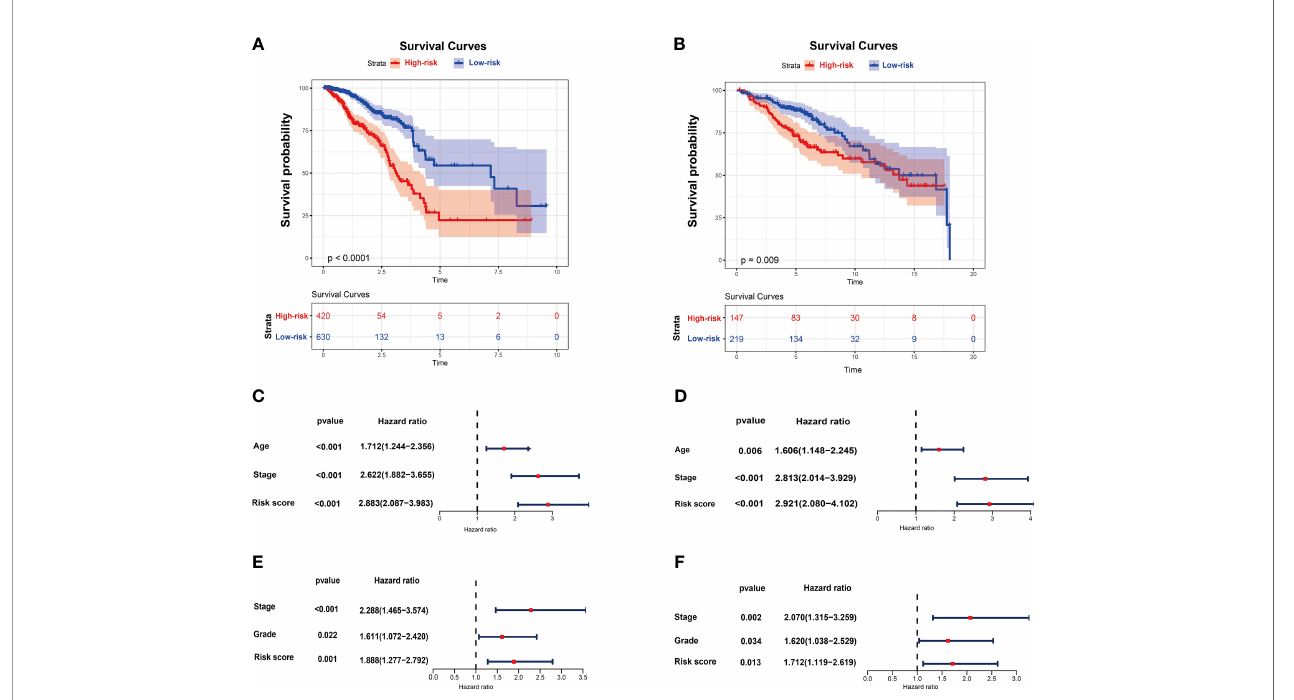
FIGURE 2 | The risk score performance in the TCGA and GEO datasets. (A) The survival plot of OS in TCGA. (B) The survival plot of OS in GSE86166. (C) Univariate Cox regression analyses of the risk score and clinicopathological parameters in TCGA. (D) Multivariate Cox regression analyses of the risk score and clinicopathological parameters in TCGA. (E) Univariate Cox regression analyses of the risk score and clinicopathological parameters in GSE86166. (F) Multivariate Cox regression analyses of the risk score and clinicopathological parameters in